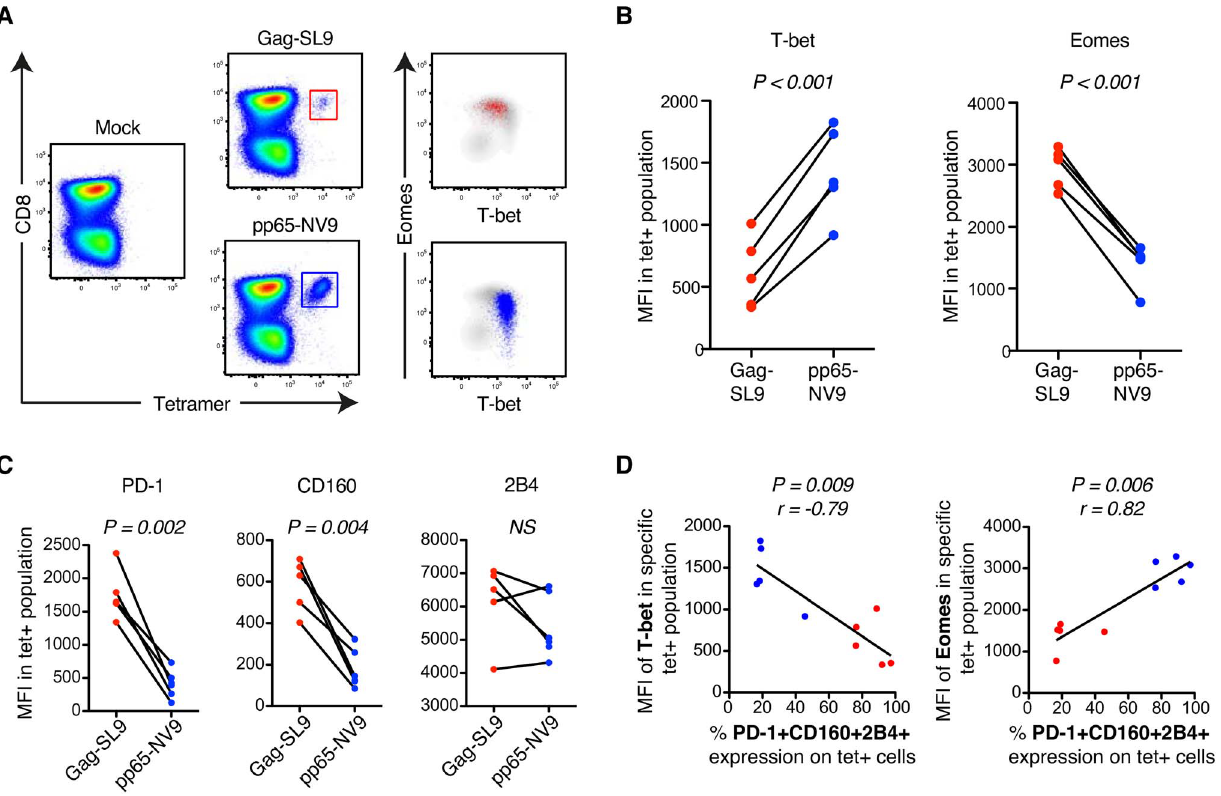
Figure 3. MHC class-I tetramer stainings of HIV- and CMV-specific CD8 + T cells in chronic HIV infection. (A) Gating strategy of HIV-Gag/ SL9-tet + (red) and CMV-pp65/NV9-tet + (blue) CD8 + T cells and their distribution within the T-bet/Eomes axis. (B) The MFI of T-bet and Eomes for Gag/ SL9-tet + and pp65/NV9-tet + cells. Paired t-tests were used to compare differences between the groups. (C) The MFI of PD-1, CD160 and 2B4 between Gag/SL9-tet + and pp65/NV9-tet + cells. Paired t-tests were used to compare differences between the groups. (D) Correlation analysis between the frequency of virus-specific PD-1 + CD160 + 2B4 + cells and MFI of T-bet or Eomes. Spearman non-parametric test was used to test for correlations.